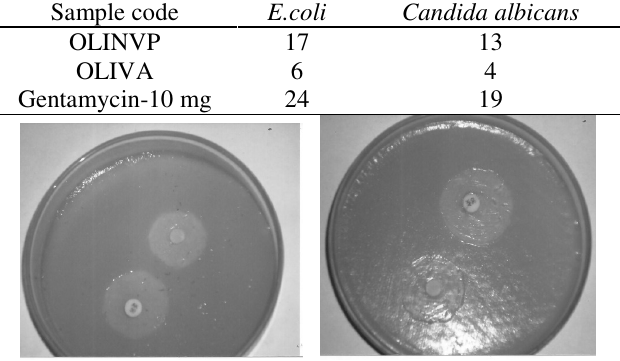
Figure 12. Antimicrobial studies of OLINVP with zone of